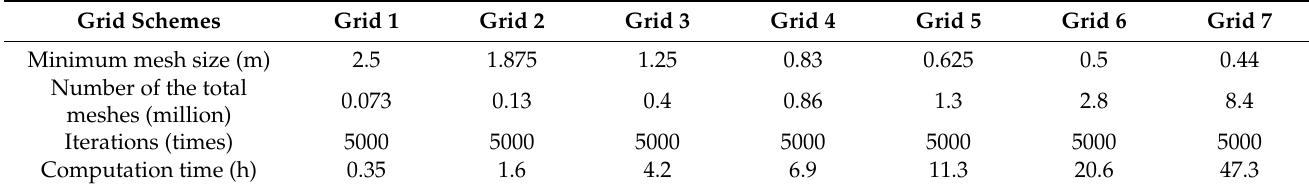
Table 1. The computation time of different grid schemes for Butterfly.